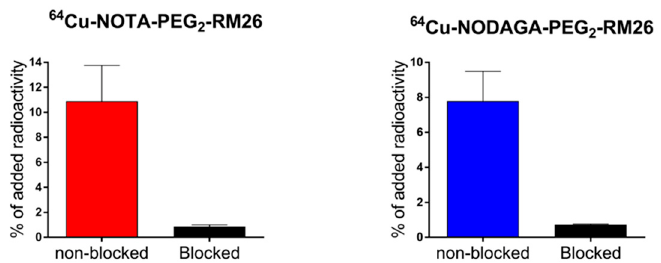
Figure 2. Binding specificity of [ 64 Cu]Cu-X-RM26 (X = NOTA-PEG 2 , NODAGA-PEG 2 ) to gastrin-releasing peptide receptor (GRPR)-expressing PC-3 cells. Blocked dishes were pre-saturated with 300-fold excess non-labeled conjugates. Cell-associated activity was calculated as a percentage of total added activity. Data are presented as average ± standard deviation.